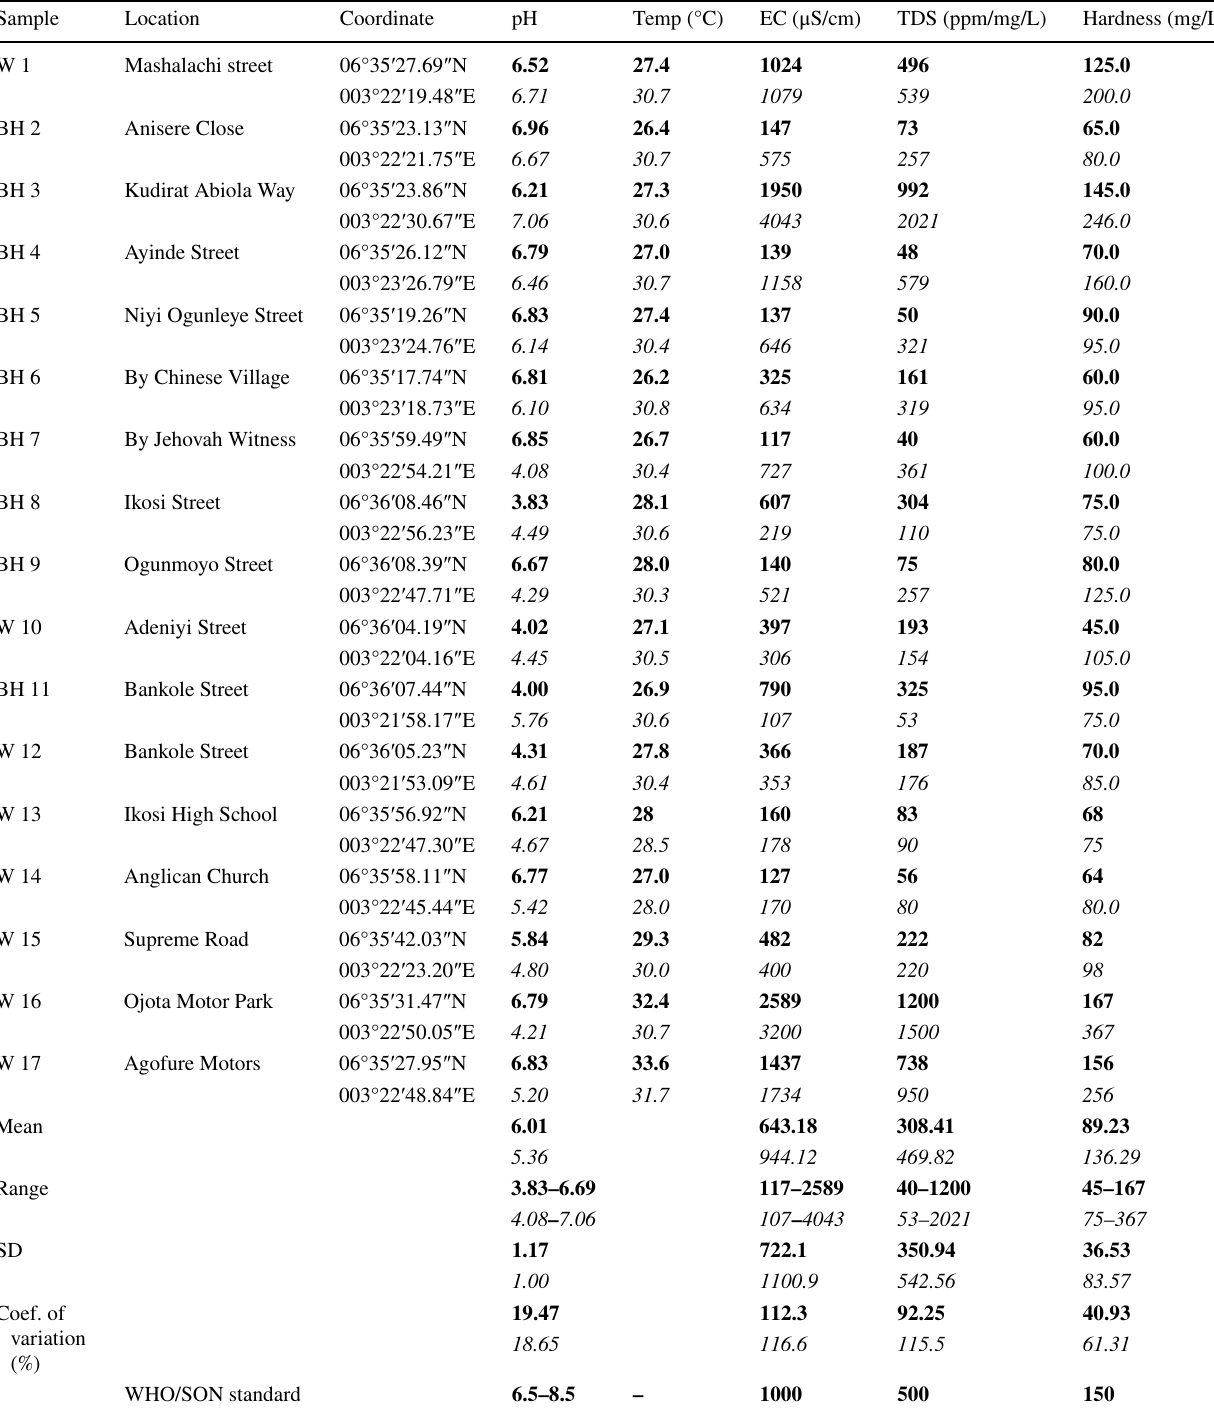
Table 1 Seasonal paired-sample statistics of groundwater physical parameters around Olusosun landfill